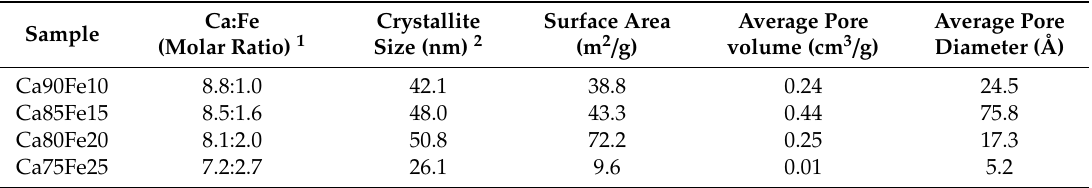
Table 2. Summary of the prepared catalysts.